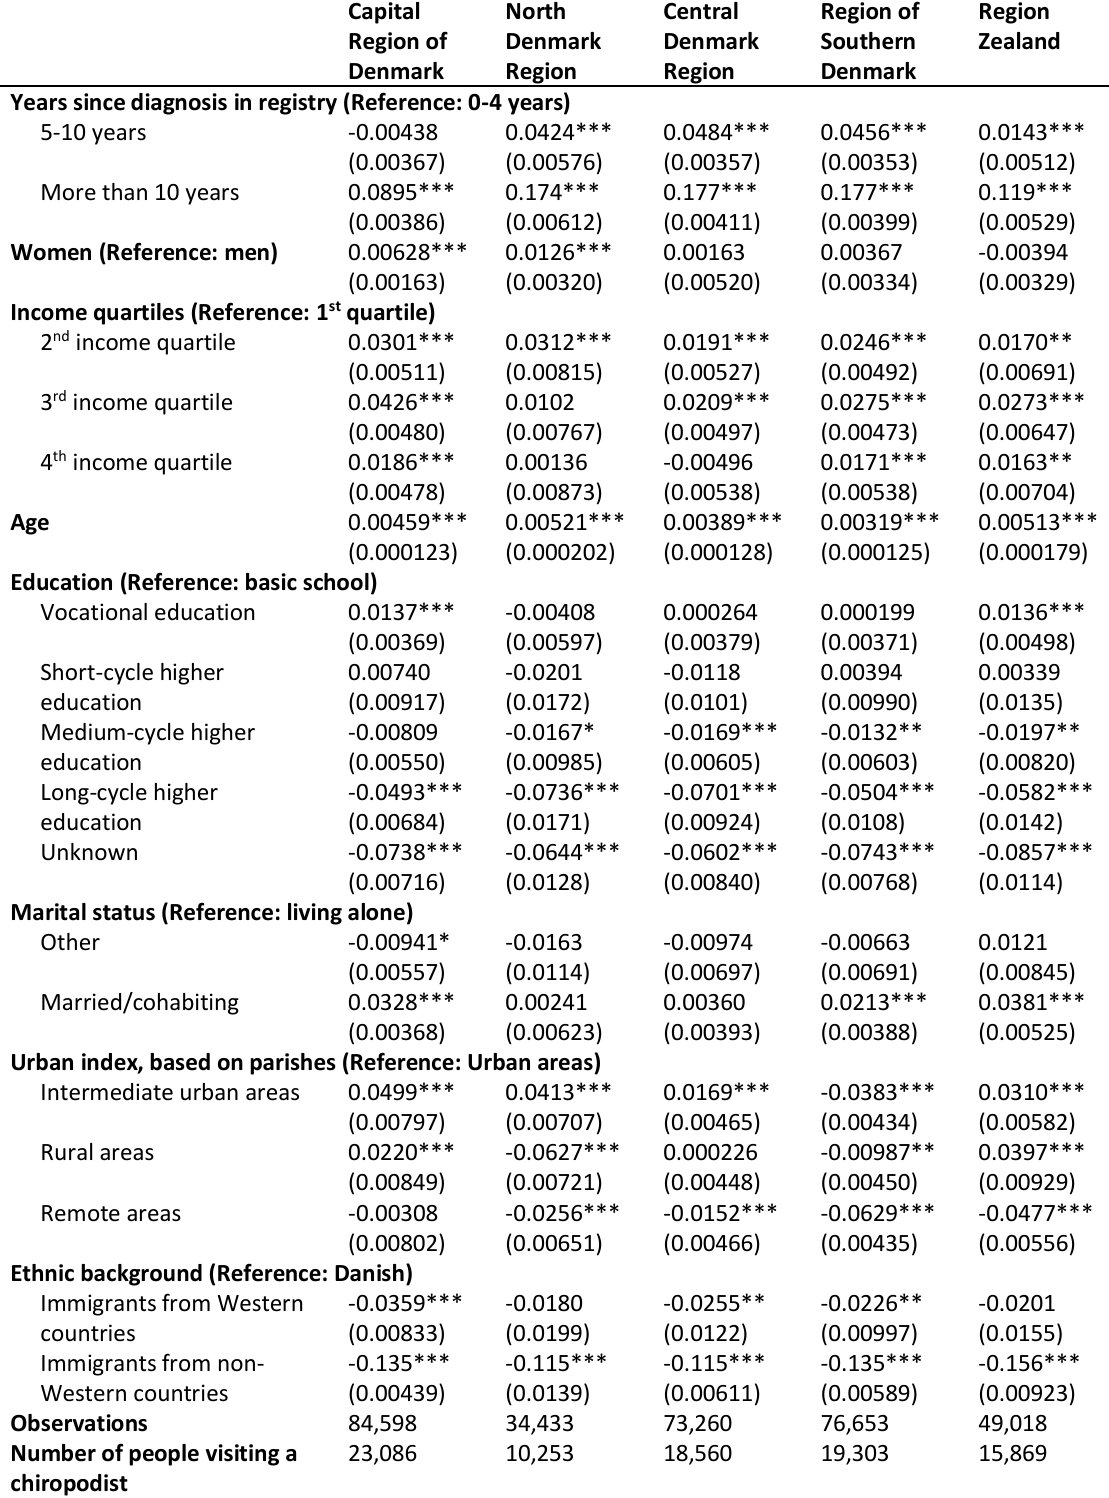
Table 3: Regional conditional models, 2012, marginal